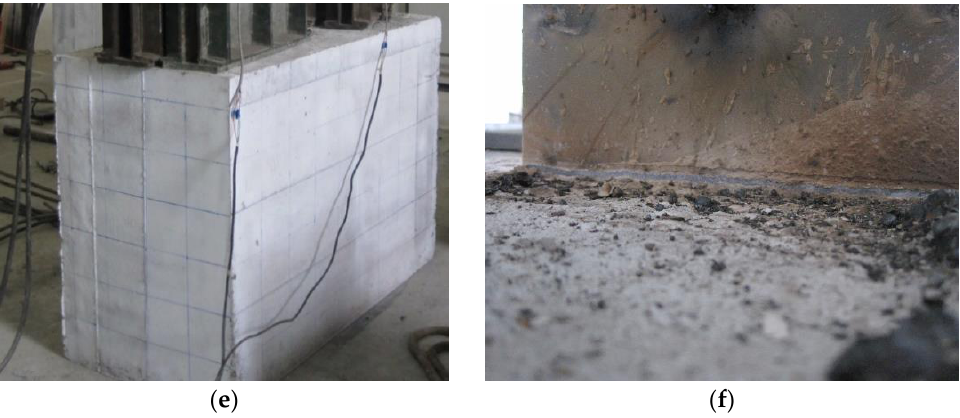
Figure 3. Failure modes of pull-out specimens. ( a ) the crack development of PA specimens; ( b ) the failure mode of the perforated rebars in PA specimens; ( c ) the crack development of PB specimens; ( d ) the failure mode of the perforated rebars in PB specimens; ( e ) the crack development of PB specimens; ( f ) the junction between the steel plate and top of the concrete in PC specimens.